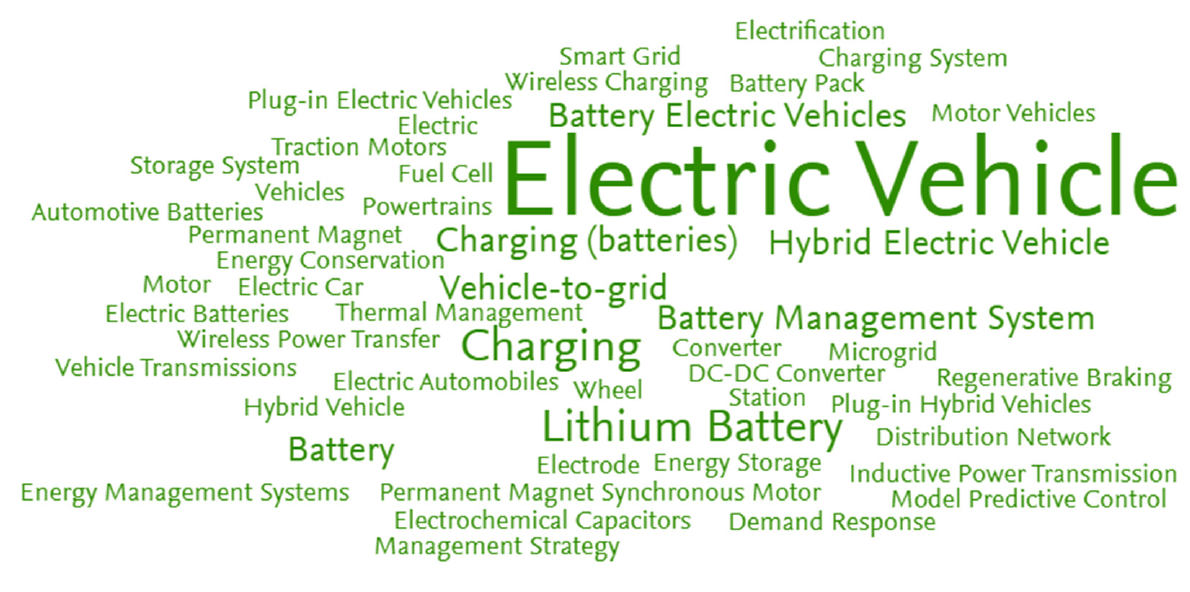
Figure 3. Key phrases based on XEV publications in 2021.